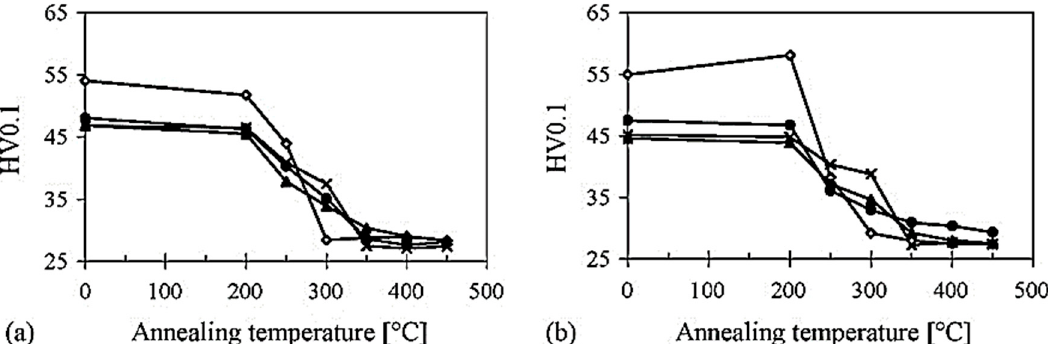
Figure 16. Hardness versus the annealing temperature of ARBed Al-Fe-Mn-Si sheets with ( a ) two cycles, ( b ) six cycles at 250 °C ( ■ ), 300 °C ( ▲ ) and 350 °C (×) and in cold-rolled condition ( ◊ ) [117].